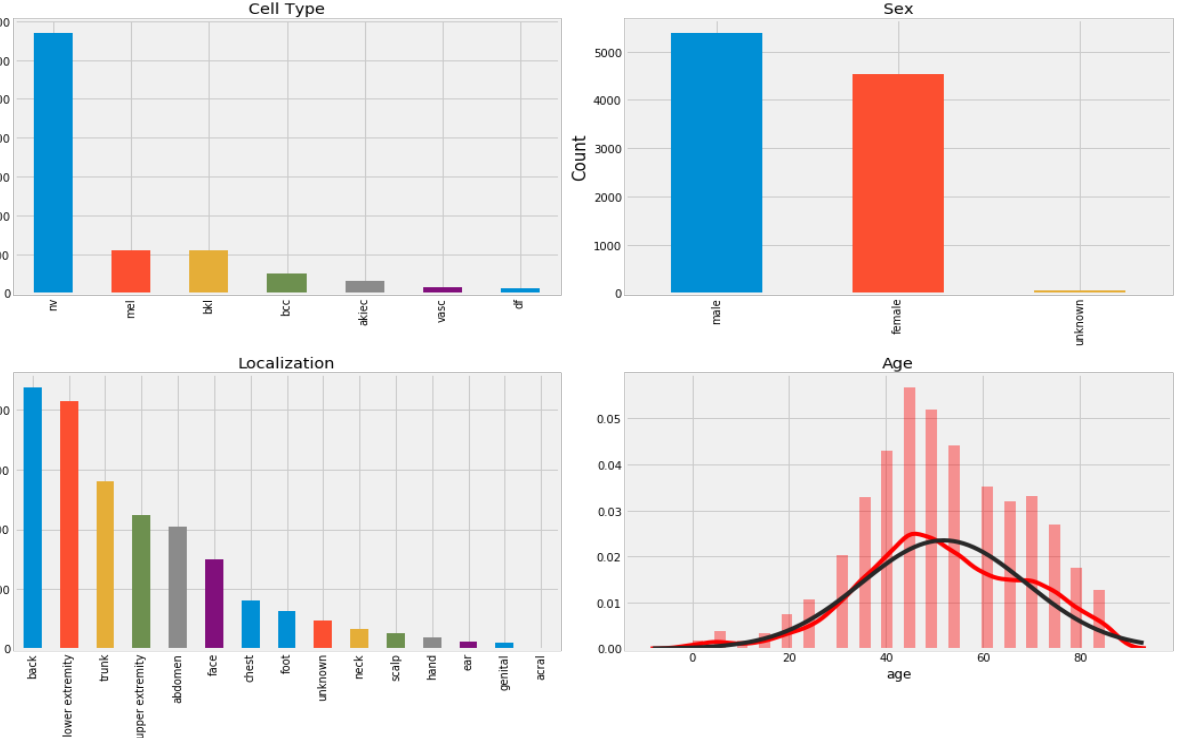
Figure 1. Distribution of sample in HAM10000 dataset according to patients’ history and type of pigmented skin lesions (PSLs).